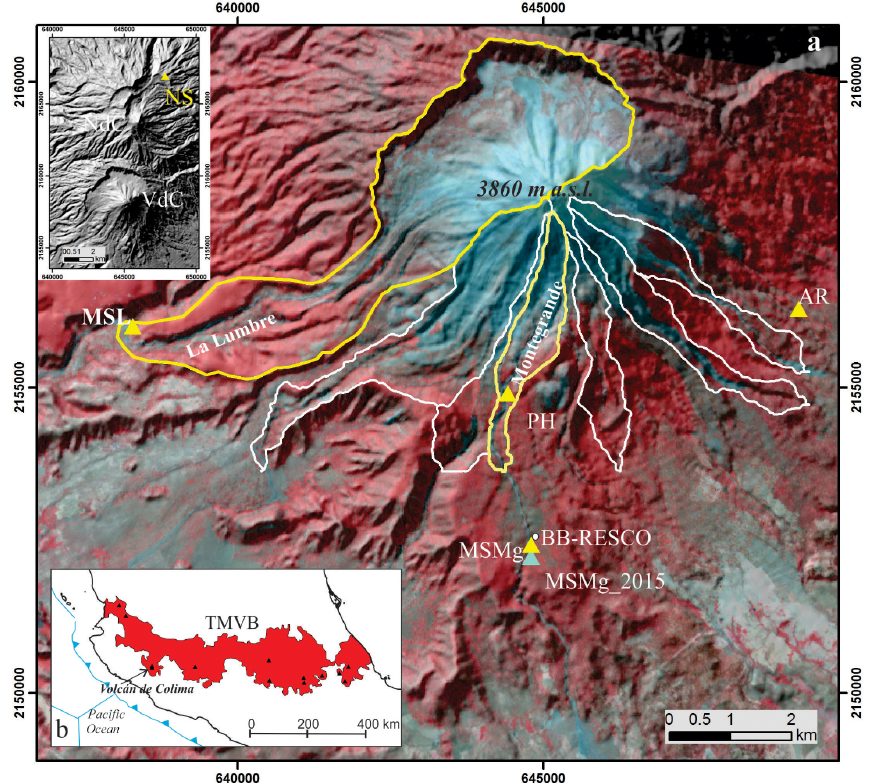
Figure 1. (a) Aster image (4, 5 and 7 bands in RGB combination) wherein the main watersheds at Volcán de Colima are represented. The locations of the monitoring stations are indicated. The inset shows the location of the rain gauge of the Meteorological National Service at the summit of the Nevado de Colima Volcano. (b) Sketch map of the Trans-Mexican Volcanic Belt (TMVB) and the Volcán de Colima location. Black triangles denote the main active volcanoes in